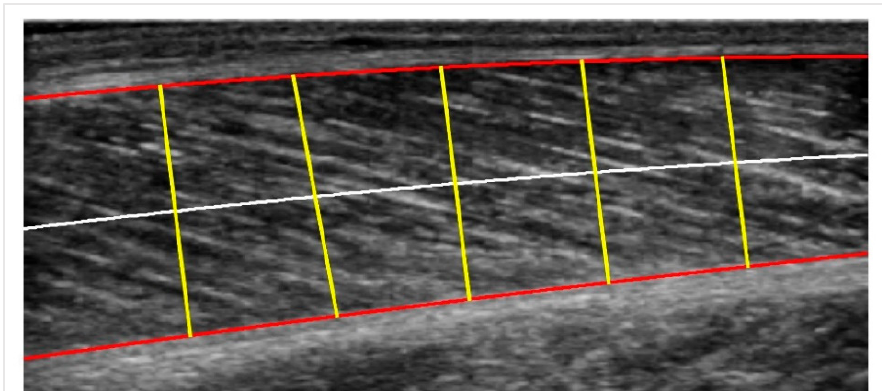
Figure 4. Centerline Distance: the red curves are the two boundaries; the white line is the centerline, and the yellow lines are the perpendicular chords to the centerline used for calculating the muscle thickness.